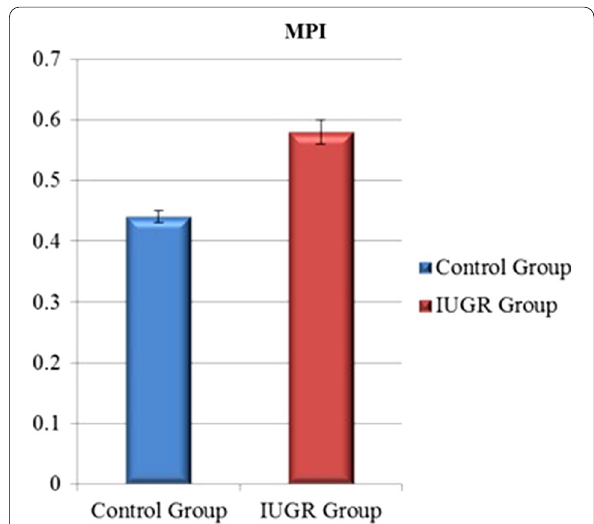
Fig. 3 Comparison between control and IUGR groups according to